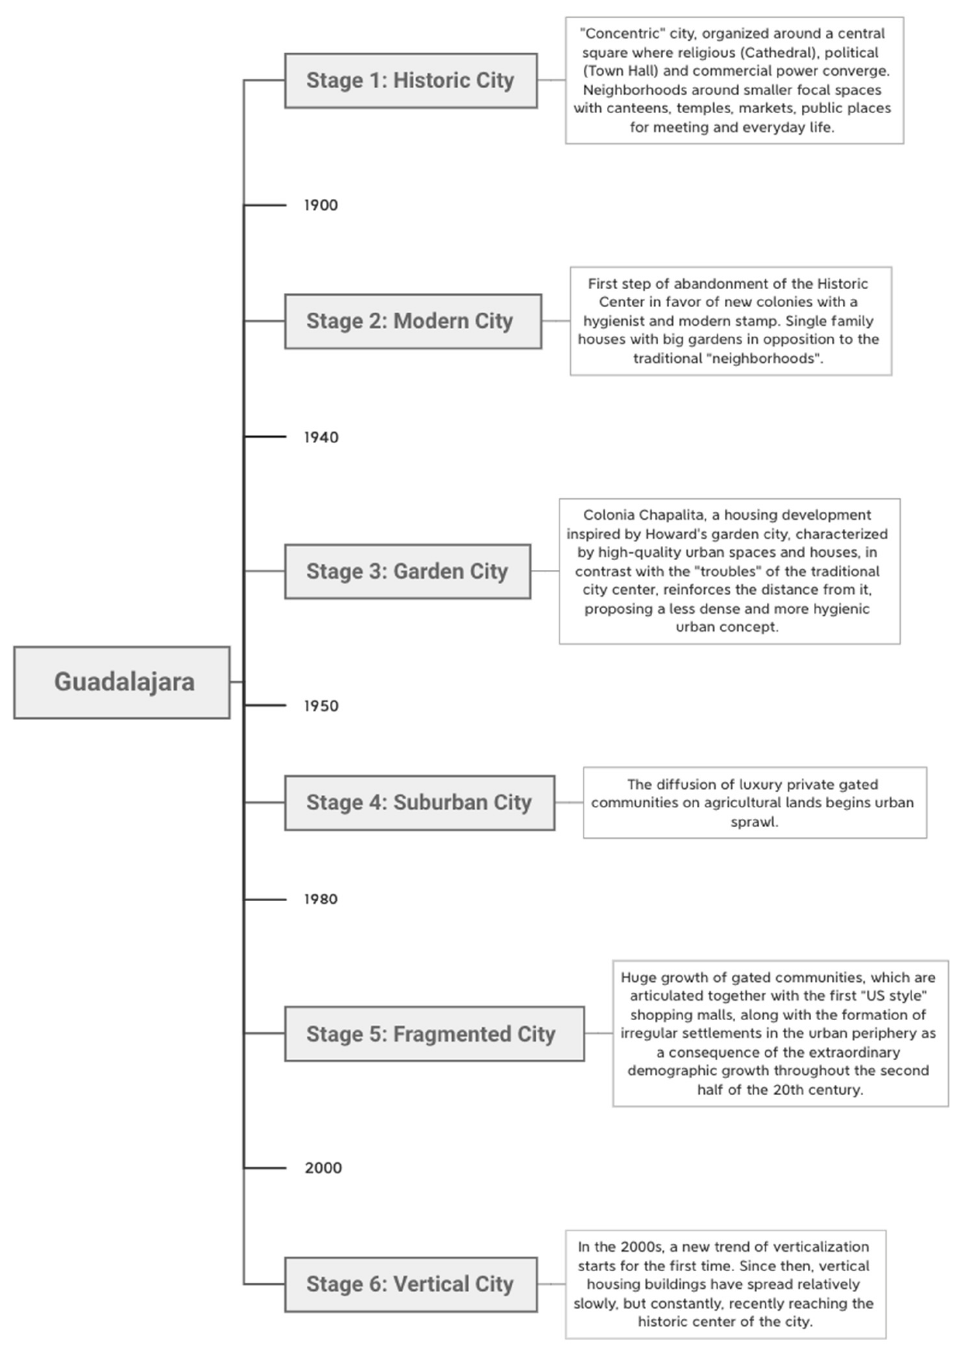
Figure 5. Summary of urban development and housing in Guadalajara. Source: Own elaboration.